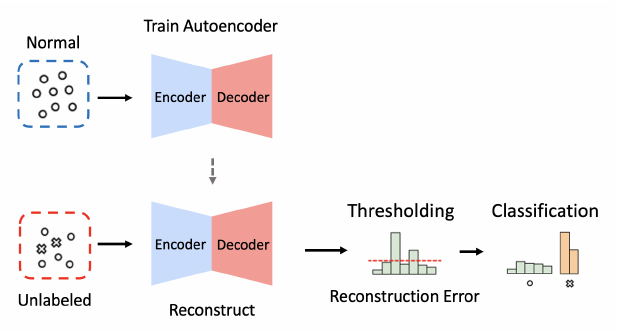
Figure 1. The overall process of intrusion detection when using the dimension reduction (i.e., Encoder) and reconstruction (i.e., Decoder) methods of